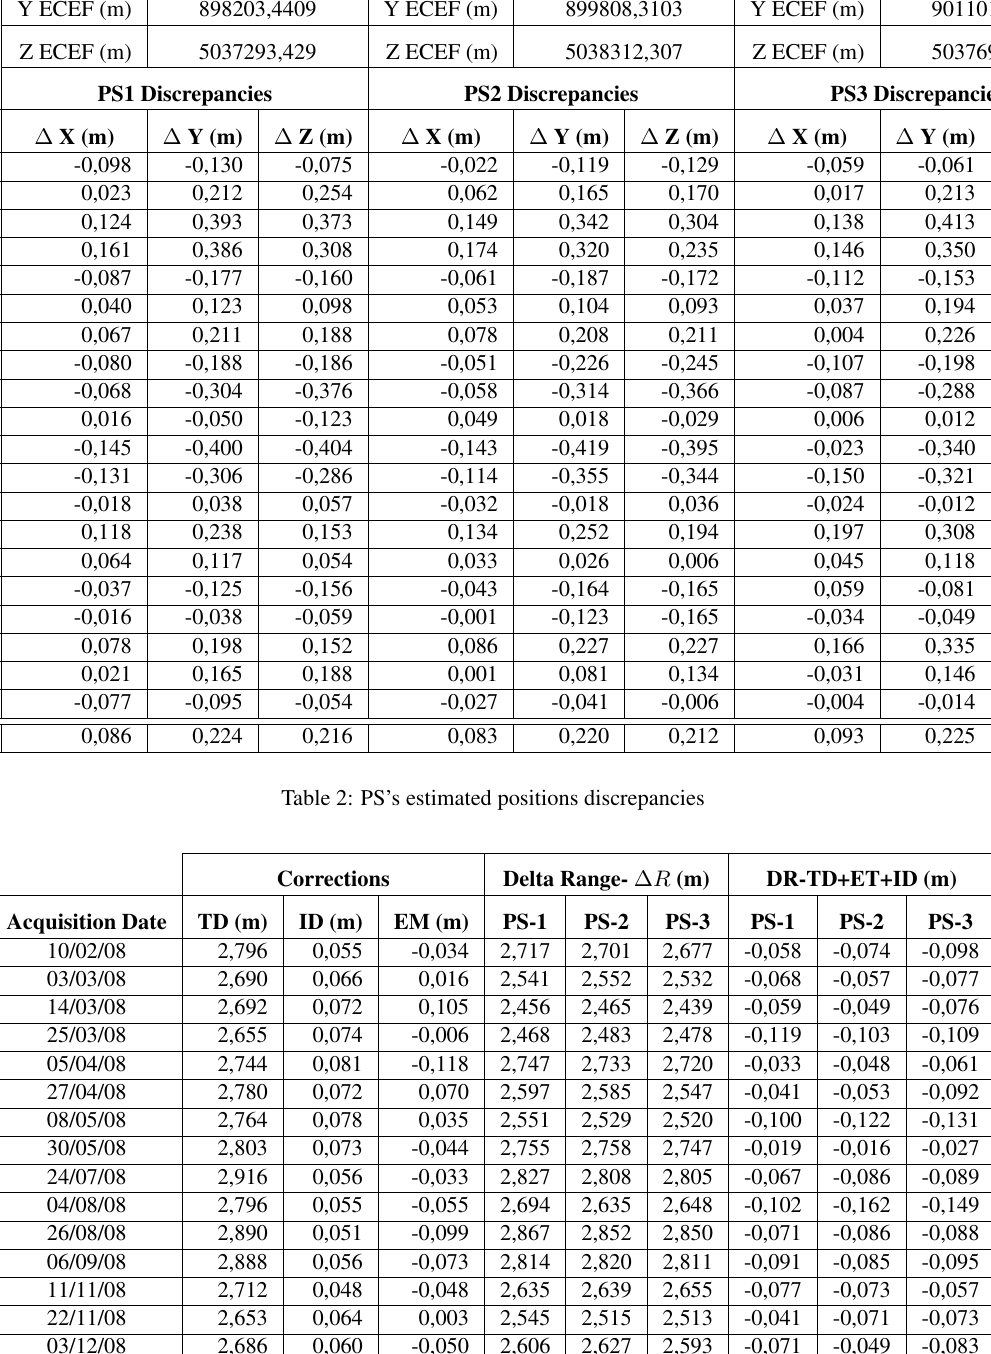
Table 3: Absolute PS’s accuracy